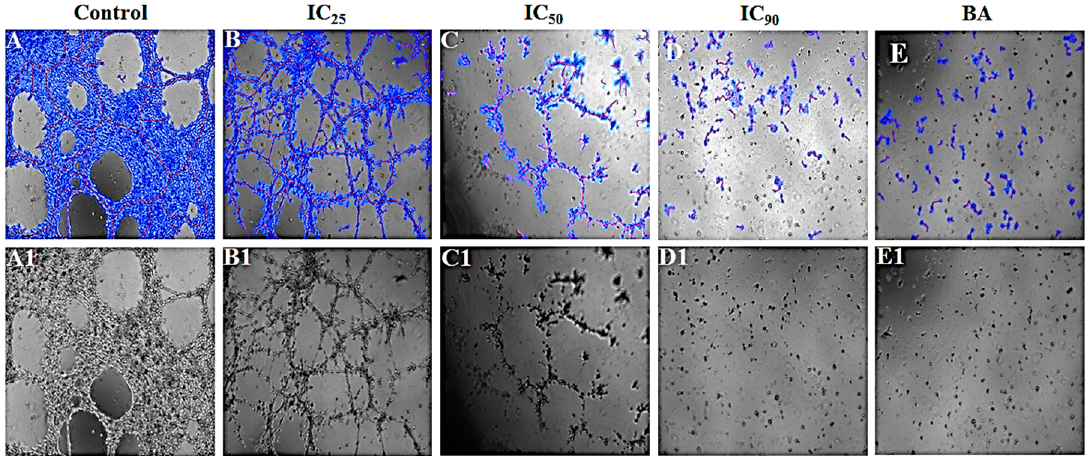
Figure 7. Photomicrographic representations of the effect of 50% ME of P. niruri whole extract on EA.hy926 cell tube formation. A , B , C , D , and E represent images analyzed using Wimasis Image Analysis software (Wimasis GmbH, Munich, Germany), while A1 , B1 , C1 , and E1 represent raw images. BA: betulinic acid.